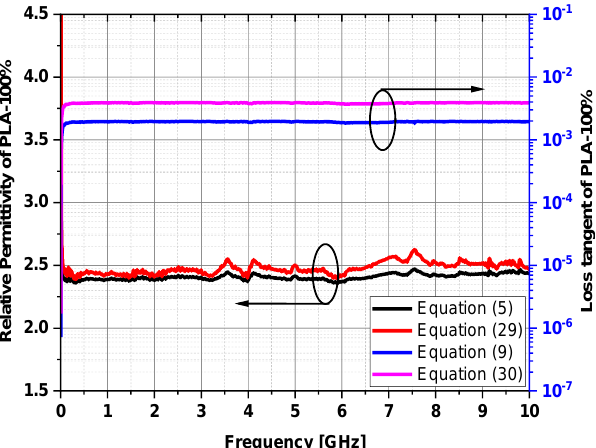
Figure 9. Relative permittivity and loss tangent of the semi-flex measured with the circular coaxial fixture.